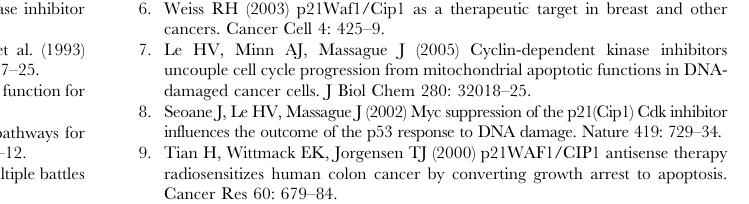
Figure S1 Role of p21 and p53 in cell death induced by serum nutrient starvation. (A and B) The indicated HCT116 cells were transfected with the indicated siRNA. 48 h later, cells were starved in EBSS medium for 24 h (EBSS) or not (CM). Viability of the indicated cells placed under starvation during 24 h was analyzed by PI staining and flow cytometry. Data are mean 6 SEM of three independent experiments. Figure S2 Enhancement of p21 protein level in serum withdraw medium. HCT116 wild-type cells were placed in complete medium (CM), in serum withdrawn medium (SW) or starved 24 h in EBSS medium (EBSS). Western blot analysis was performed to detect p21 expression. Figure S3 Enhancement of Puma protein level in p53 2 / 2 HCT116 cells. HCT116 p53 2 / 2 cells were placed in complete medium (CM) or starved 24 h in EBSS medium (EBSS). Western blot analysis was performed to detect Puma